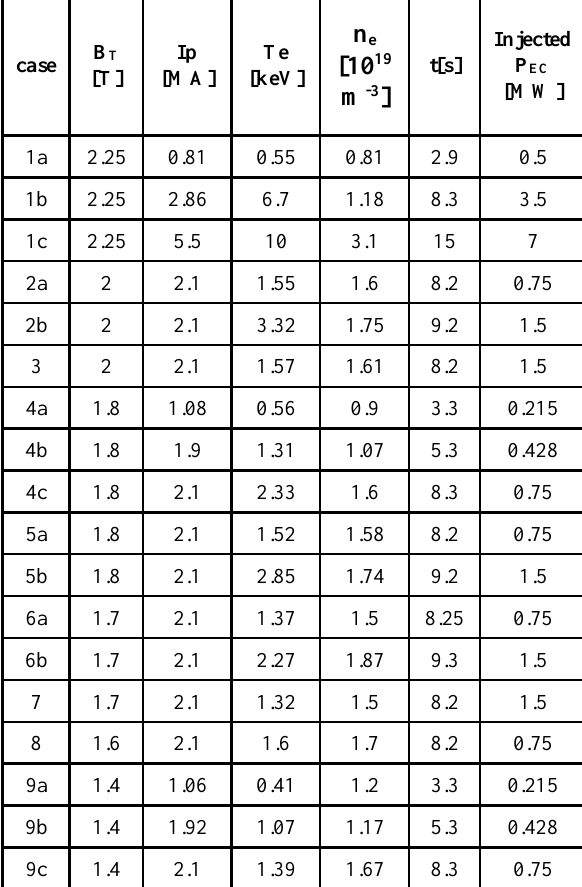
Table 1. ECRF heating cases during the current ramp-up